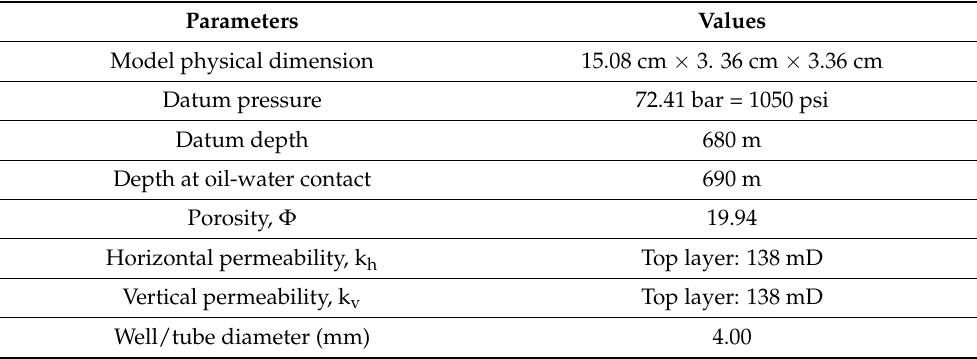
Table A5. Reservoir and Simulation Model